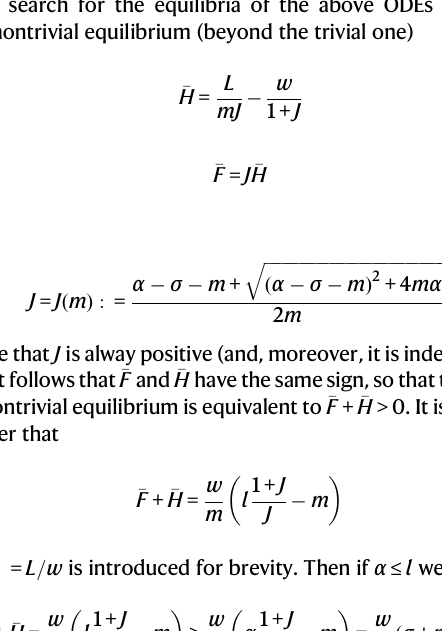
cyclingpro fi leswereadopted:onecycleat95°Cfor10min,40cyclesat 95°C for 15s and 60°C for 1min, and one cycle at 68°C for 7min. Individual survival and colony